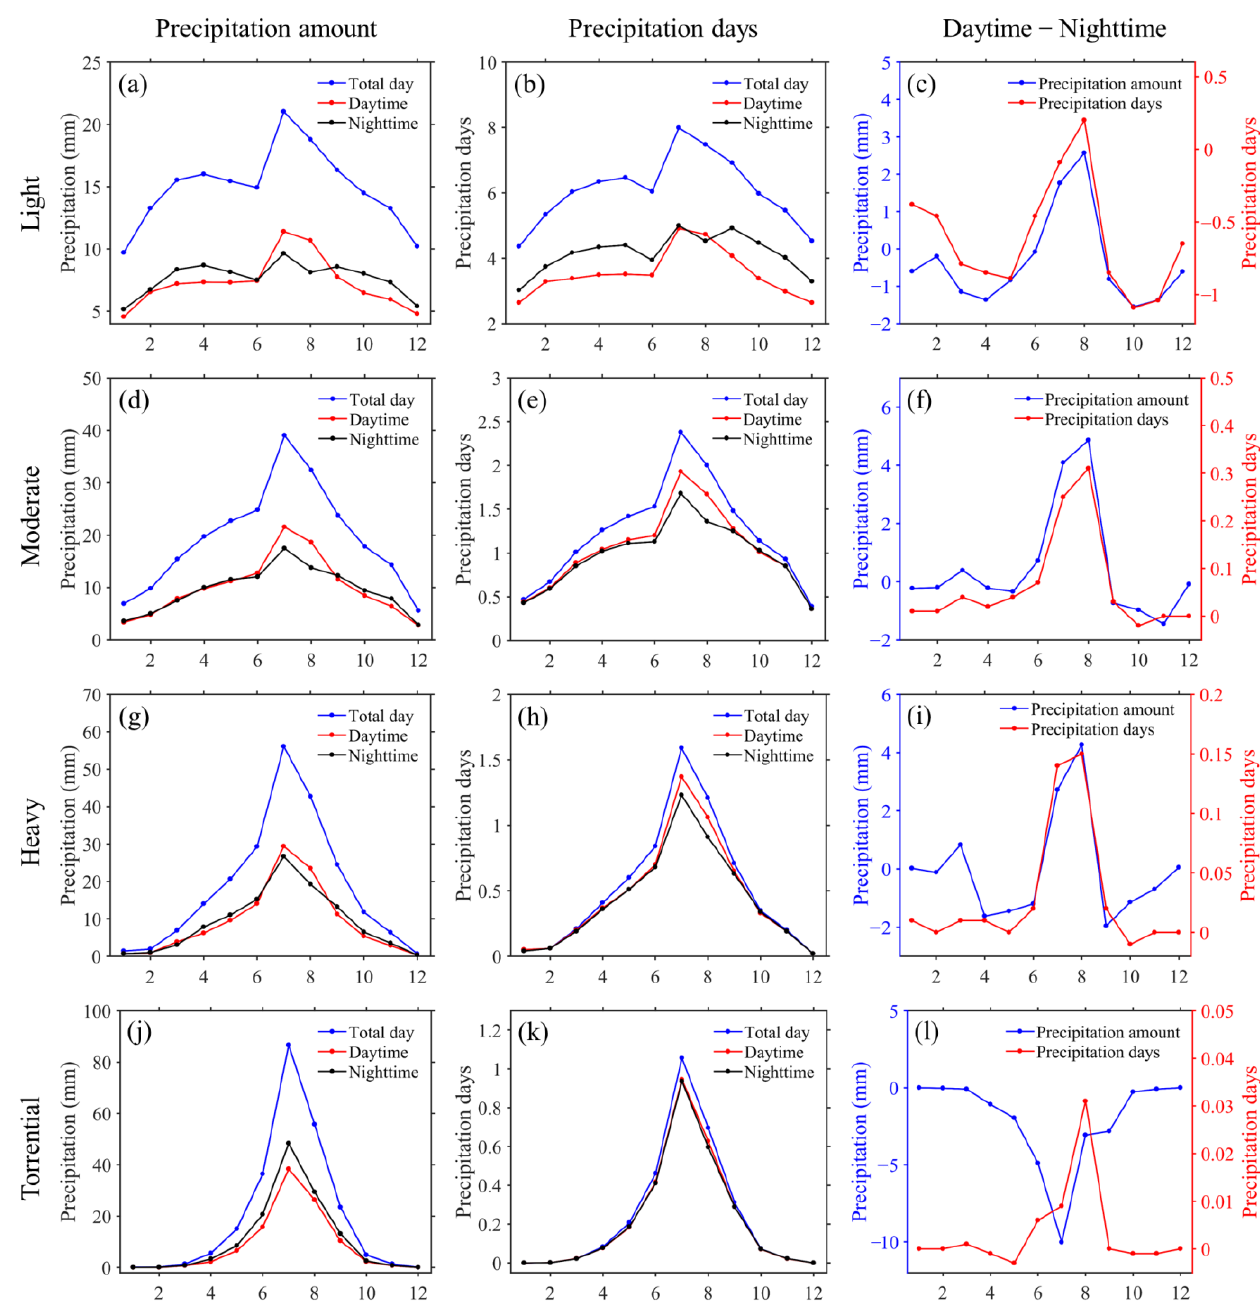
Figure 8. Seasonal cycles in the amount, days, and their difference (daytime minus nighttime) for total, daytime, and nighttime precipitation at different grades of intensity. The rows represent changes at different grades of precipitation intensity (light, moderate, heavy, and torrential), and the columns represent changes in different precipitation indices (precipitation amount, precipitation days, and daytime minus nighttime).